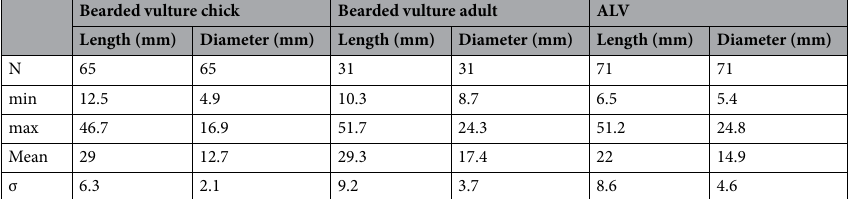
Bearded vulture